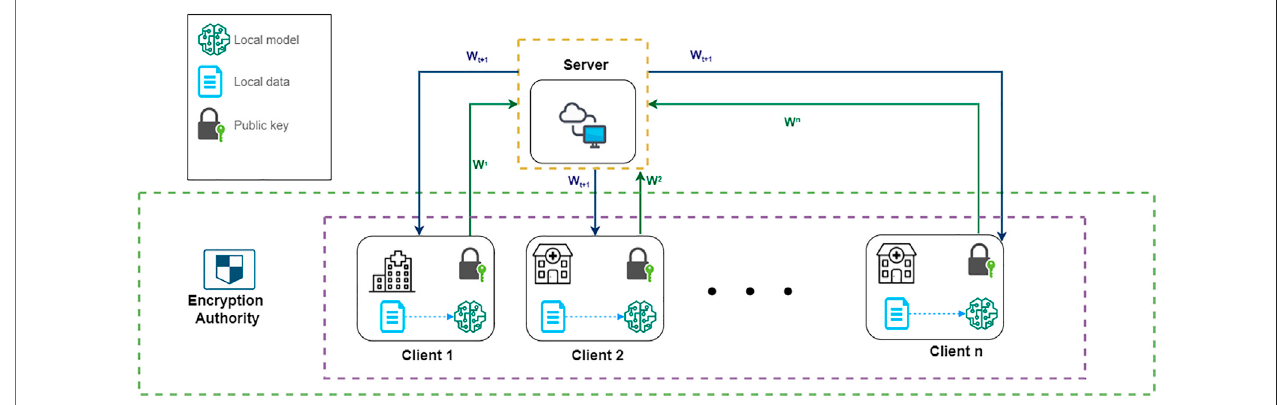
FIGURE1| AsystemmodelofourFLarchitecture. ω 1 , ω 2 , ... ω n representtheencryptedlocalmodelparametersofeachclient. ω t +1 representstheupdatedglobal model ’ s parameter after